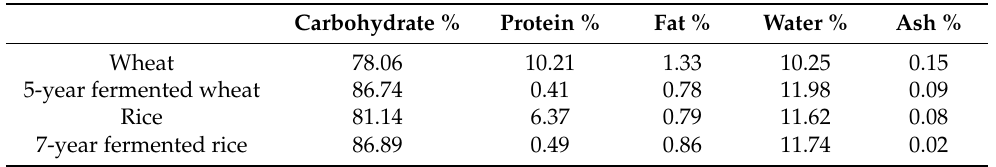
Table 2. Nutritional composition of fresh wheat starch, 5-year fermented wheat starch, fresh rice starch and 7-year fermented rice starch.